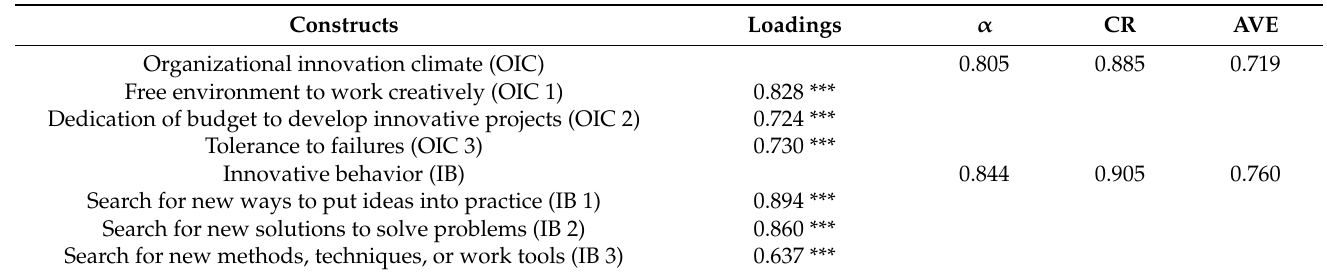
Table 2. Statistical values of the reflective